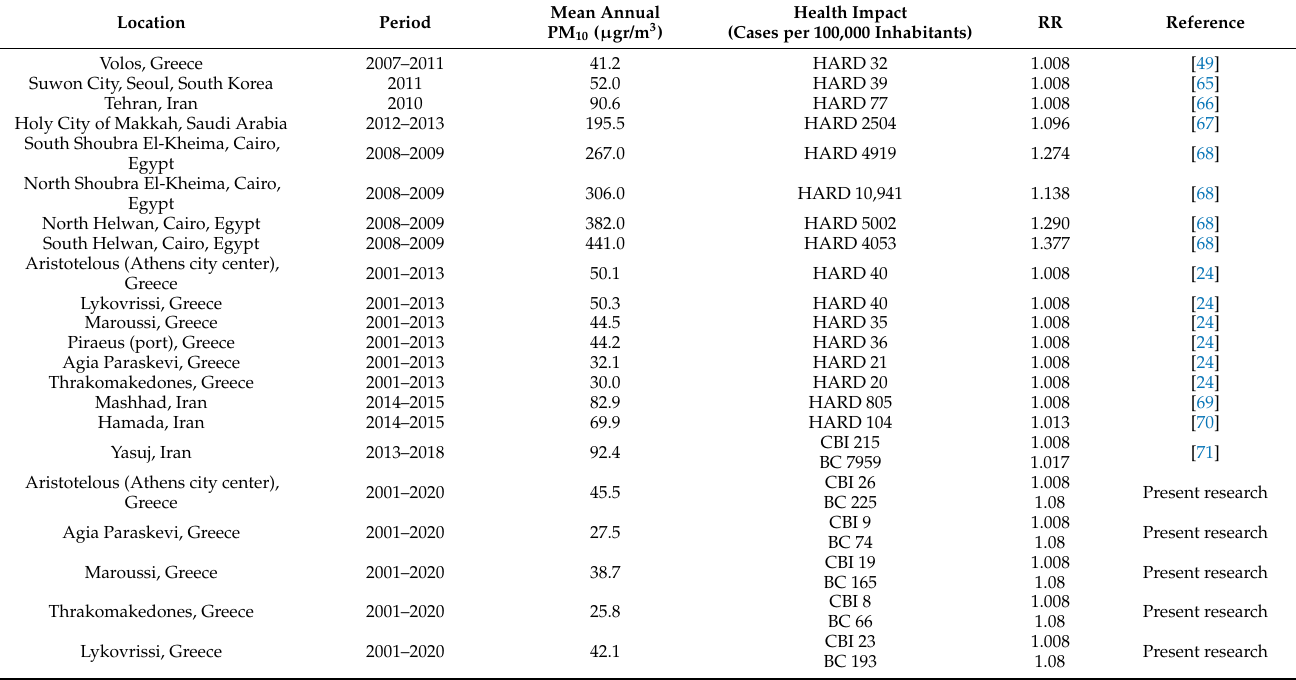
Table 3. Comparative analysis of health endpoint cases per 100,000 inhabitants due to PM 10 exposure for different sites